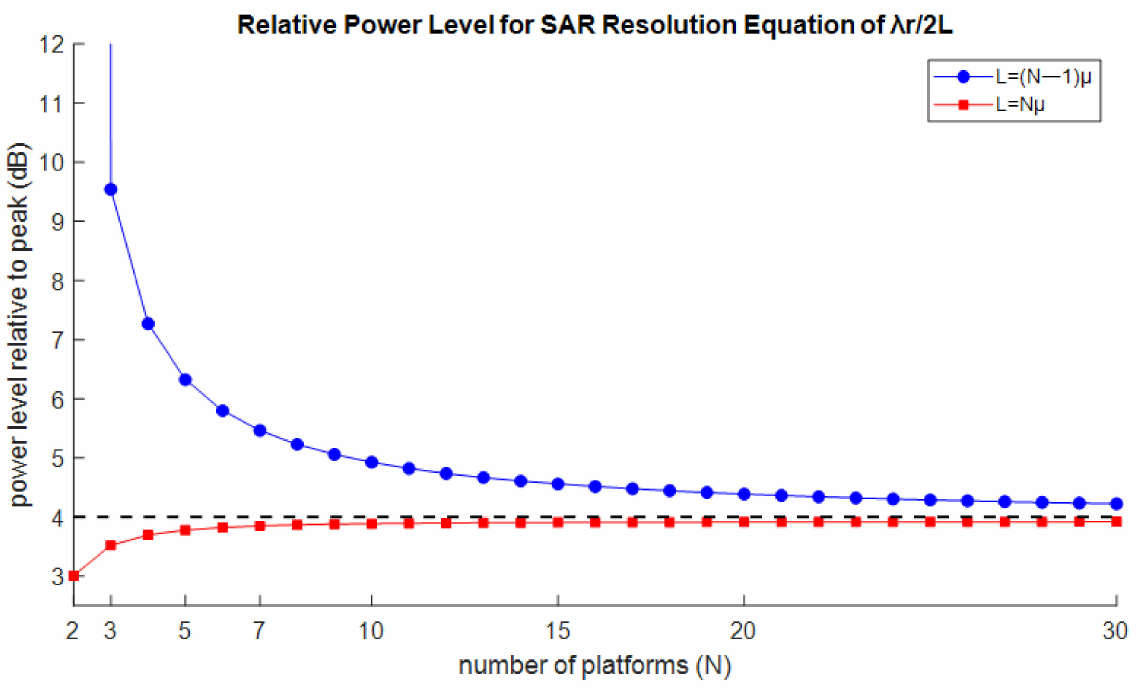
Figure 2. Relative power level for synthetic aperture radar (SAR) resolution equation of λ r 0 /2 L n vs. number of platforms ( N ). When L n = ( N − 1 ) µ n and N = 2, half of the SAR resolution equation corresponds to the null of point spread function and therefore the relative power level goes to infinity for the blue curve for N = 2. For L n = ( N − 1 ) µ n , the power level is ~9.5 dB when N = 3 and approaches ~4.1 dB for large N . For L n = N µ n , the power level is ~3.0 dB when N = 2 and approaches ~3.9 dB for large N